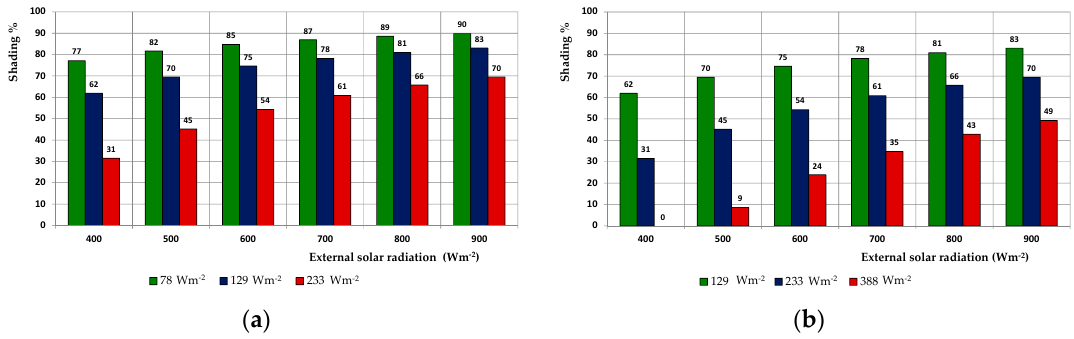
Figure 9. ( a ) Percentage of shading in the photovoltaic greenhouse to guarantee that the minimum radiation threshold that is necessary for the plants is met; ( b ) percentage of shading in the photovoltaic greenhouse to guarantee that the maximum threshold that is necessary for the plants is met.